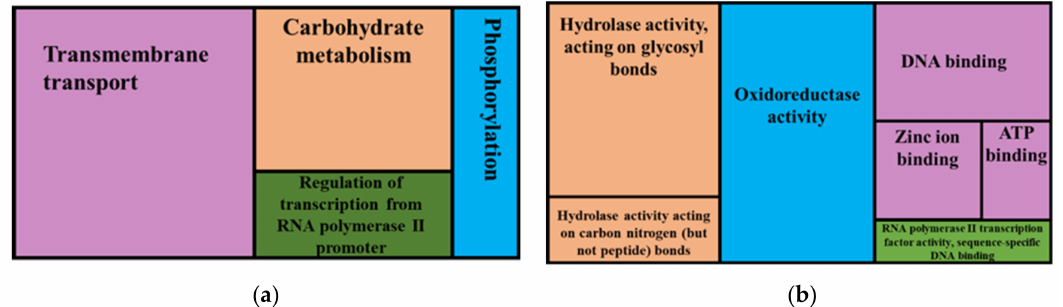
Figure 9. GO enrichment analysis for genes predicted to have moderate impact variants showing overrepresented GO terms, biological processes ( a ) and molecular functions ( b ). The whole genome annotations of the reference FSP34 were used as the test set and the genes with moderate impact variants were the test